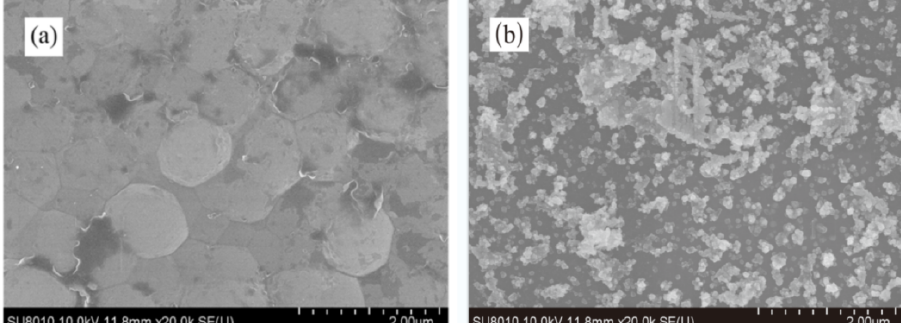
Figure 2. SEM images of ( a ) GUITAR and ( b ) the copper oxide-modified GUITAR electrode.